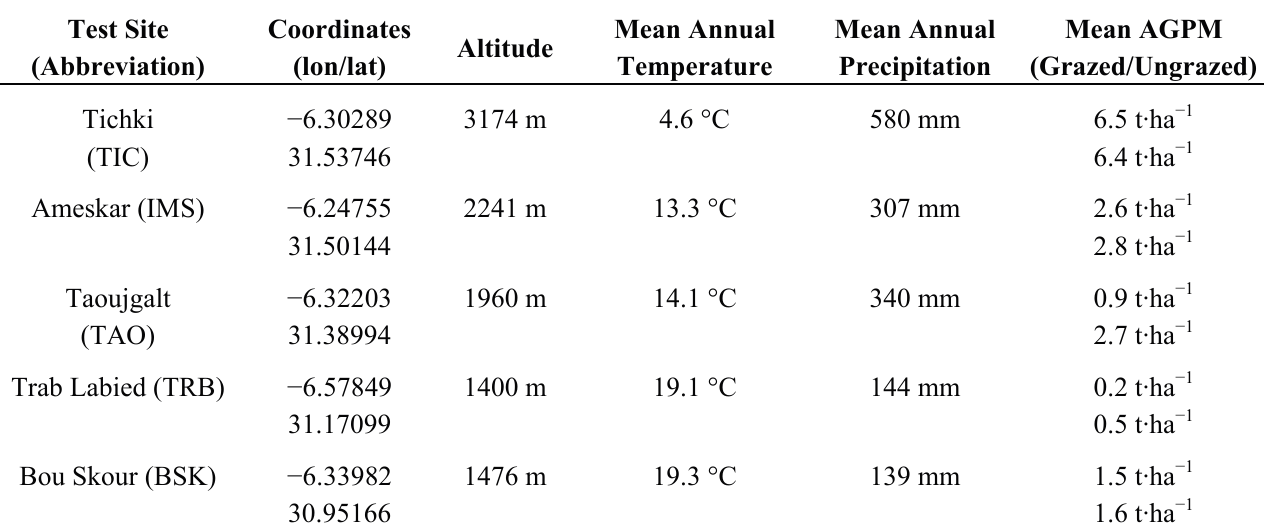
Table 1. Characteristics of five measurement sites used for calibration of our model.